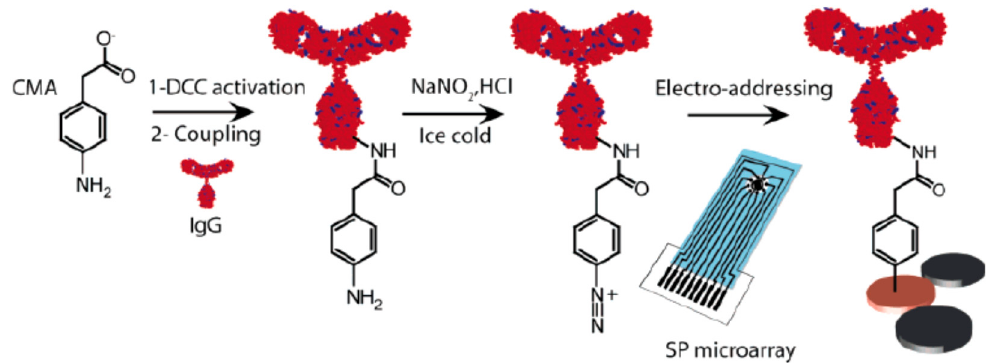
Figure 16. Electrografting of an immunoglobulin G (IgG) on an array of screen-printed electrodes. From Reference [104] with permission of Wiley.